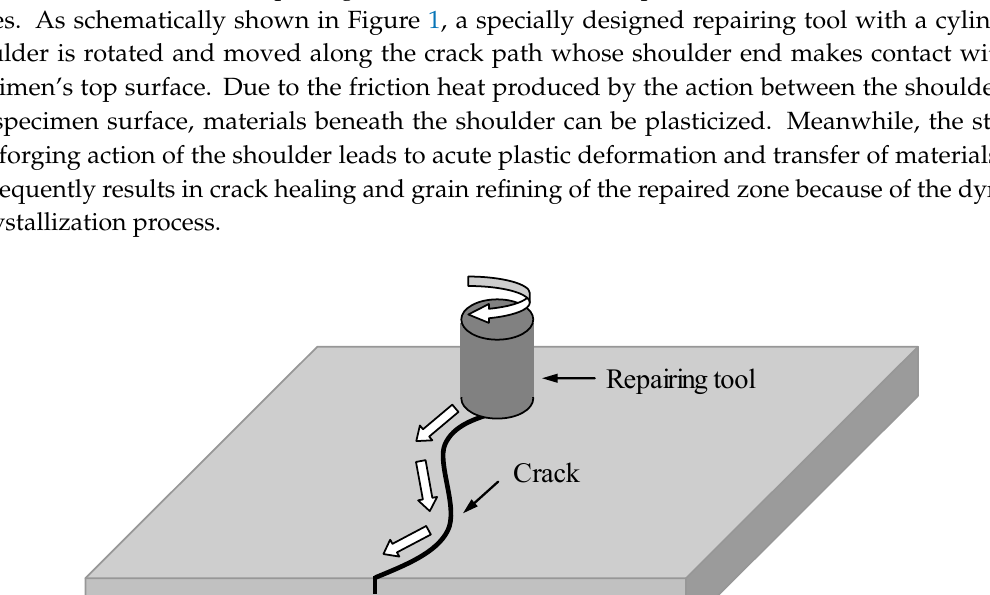
Table 1. Material properties of the 2024-T4 aluminum